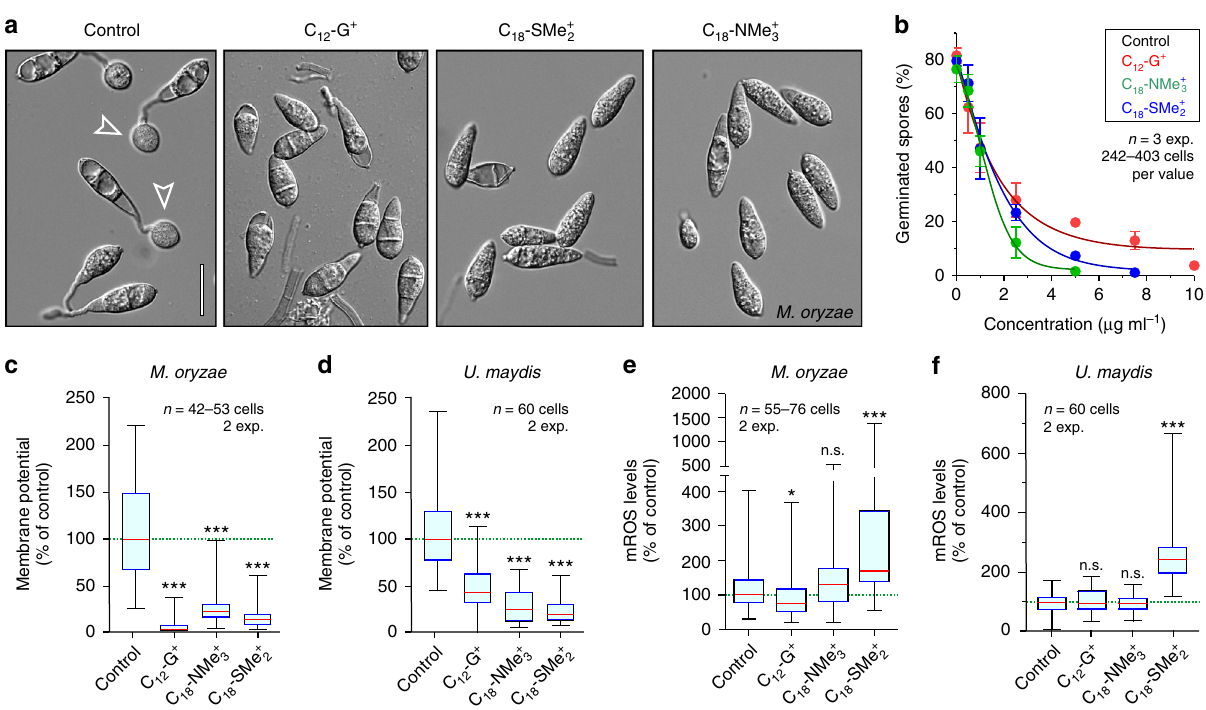
Fig. 6 Effect of C 12 -G + , C 18 -NMe 3 + , and C 18 -SMe 2 + on the rice blast fungus M. oryzae and the corn smut fungus U. maydis . a Effect of treatment of M. oryzae conidia with the solvent (control), C 12 -G + , C 18 -SMe 2 + , and C 18 -NMe 3 + . In control experiments, appressoria are formed (Control, open arrowheads), whereas all MALCs inhibit germination of M. oryzae conidia at high concentrations. Scale bar = 20 µ m. b Effect of C 12 -G + , C 18 -NMe 3 + , and C 18 -SMe 2 + on germination of M. oryzae conidia. See Table 1 for EC 50 values. c Effect of C 12 -G + , C 18 -SMe 2 + , and C 18 -NMe 3 + on mitochondrial potential in M. oryzae . Values are background-corrected TMRM fl uorescence intensity values. See also Supplementary Fig. 7b. d Effect of C 12 -G + , C 18 -SMe 2 + , and C 18 -NMe 3 + on mitochondrial potential in U. maydis . Values are background-corrected TMRM fl uorescence intensity values. See also Supplementary Fig. 7d. e Effect of C 12 - G + , C 18 -SMe 2 + , and C 18 -NMe 3 + on the mROS levels in M. oryzae . Only C 18 -SMe 2 + induces signi fi cantly mROS levels. f Effect of C 12 -G + , C 18 -SMe 2 + , and C 18 -NMe 3 + on the mROS levels in U. maydis . Only C 18 -SMe 2 + induces signi fi cantly mROS levels. See also Supplementary Fig. 7e. Values ( b ) are shown as mean ± SEM, with sample size n = 3. Non-linear regression curves were calculated as dose-response inhibition (four parameters) in Prism5. c – f Whiskers ’ plots, with 25th/75th percentiles (blue lines), medians (red line), and minimum and maximum (whiskers ends). Green lines indicate level of control median. Sample size n is indicated in each panel. Non-parametric Mann – Whitney testing ( a , c , d ); n.s. non-signi fi cant difference to control ( P > 0.05) ( d ), *** P < 0.0001 ( a , c , d ). Student ’ s t -testing with Welch correction ( f , h ); n.s. non-signi fi cance ( f , h ) and *** P = 0.0002 ( f , h ). All P -values are two-tailed. See Supplementary Table 7 for experimental conditions. All source data are provided as a Source Data fi